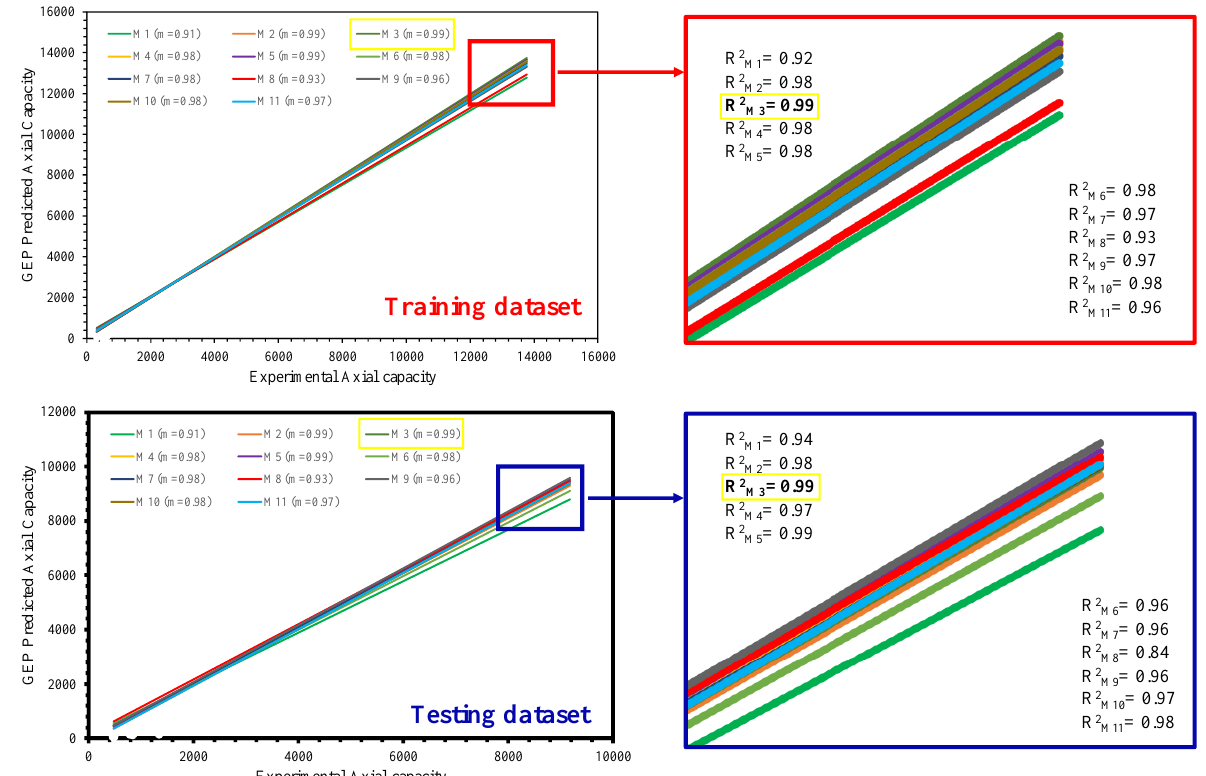
Figure 6. Comparison of regression slopes in the TR phase.